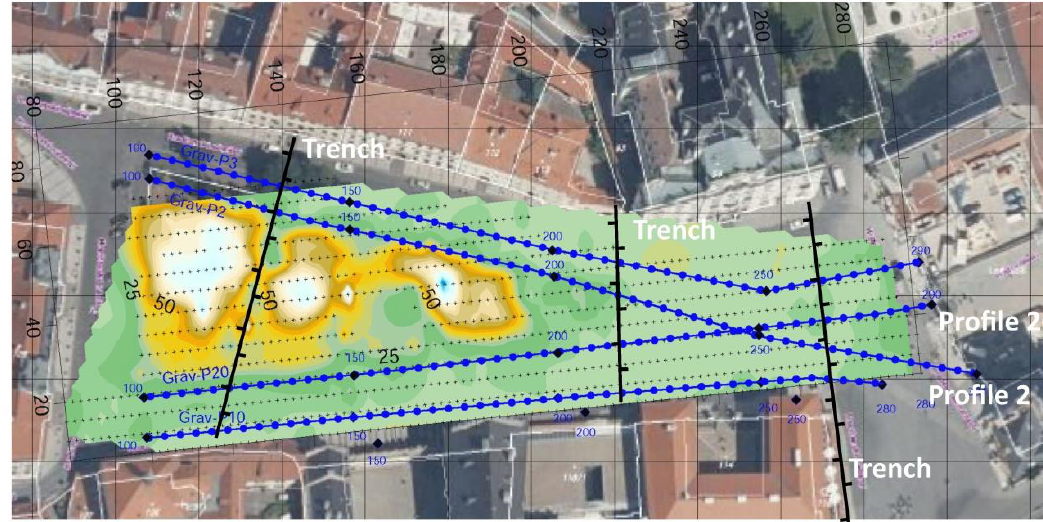
Figure 21. Hradčany Square. The map with isolines of conductivity (by DEMP), gravity profiles and interpretation of the medieval trenches.